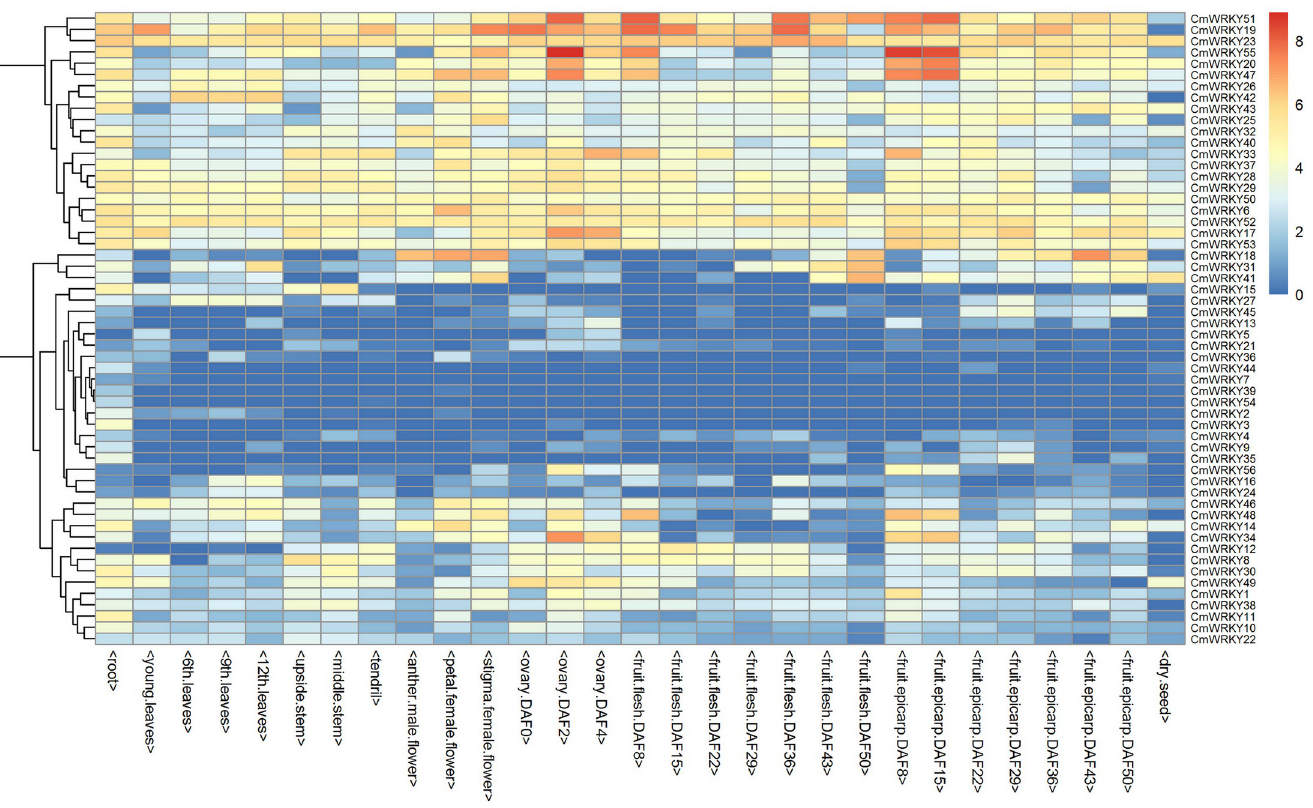
Fig 5. Expression profiles of 56 CmWRKY genes in various organs/tissues as well as different developmental stages of melon. The expression values were measured as fragments per kilobase of exon model per million mapped reads (FPKM) and shown as log2 (value + 1). The color scale is shown at the right and higher expression levels are shown in